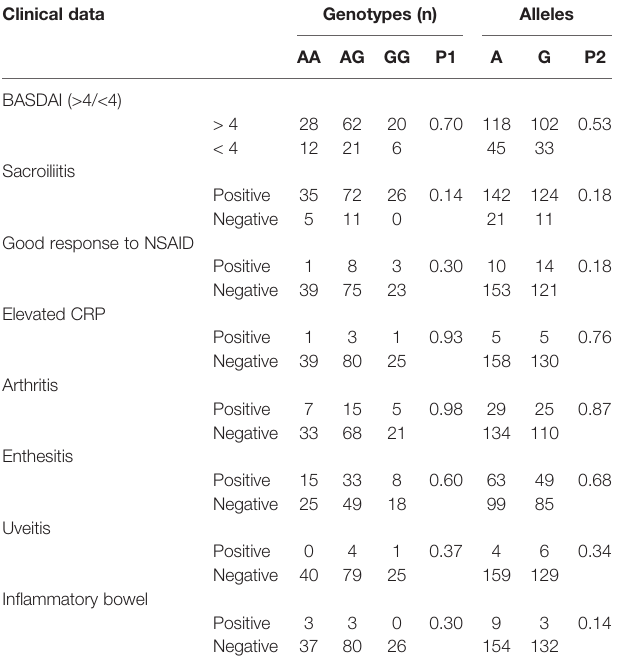
P1: Patients positive versus patients negative using 3×2 contingency table. P2: Patients positive versus patients negative using 2×2 contingency table. AS, ankylosing spondylitis; BASDAI, bath ankylosing spondylitis disease activity index; NSAID, non-steroidal anti-in fl ammatory drugs; SpA, spondyloarthritis; CPR, c-reactive protein.